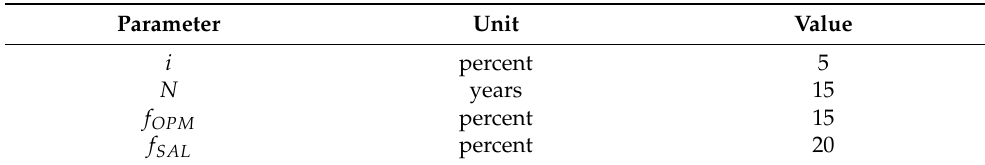
Table 3. The required parameters for the calculation of CPL [1]. Parameter Unit Value i percent 5 N years 15 f OPM percent 15 f SAL percent